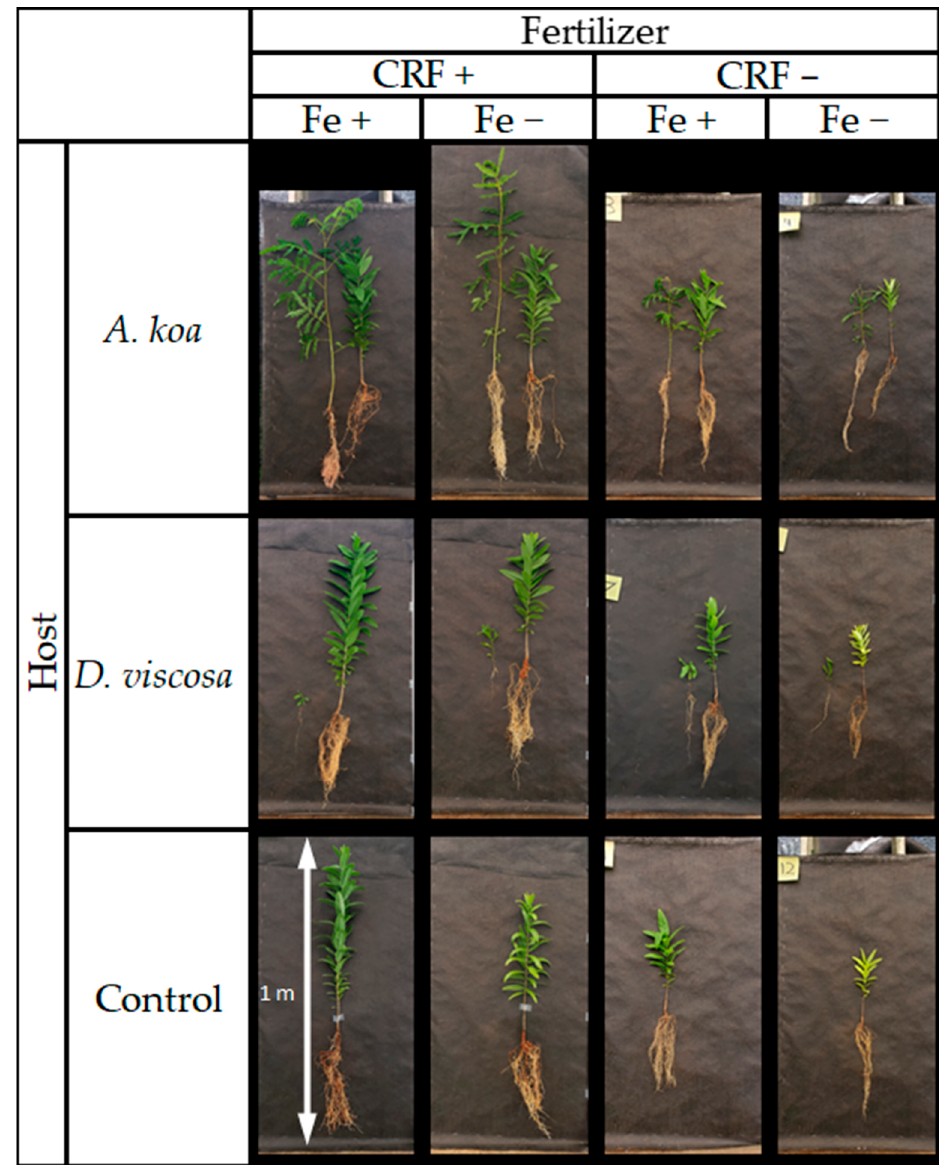
Figure 2. Pictures of representative seedlings from each of the twelve unique treatments show that seedlings that received CRF were significantly larger than seedlings that did not receive CRF. The D. viscosa hosts were much smaller than the A. koa hosts at the end of the experiment. Fe+ = chelated Fe applied; Fe − = control; CRF+ = CRF applied; CRF − = control.